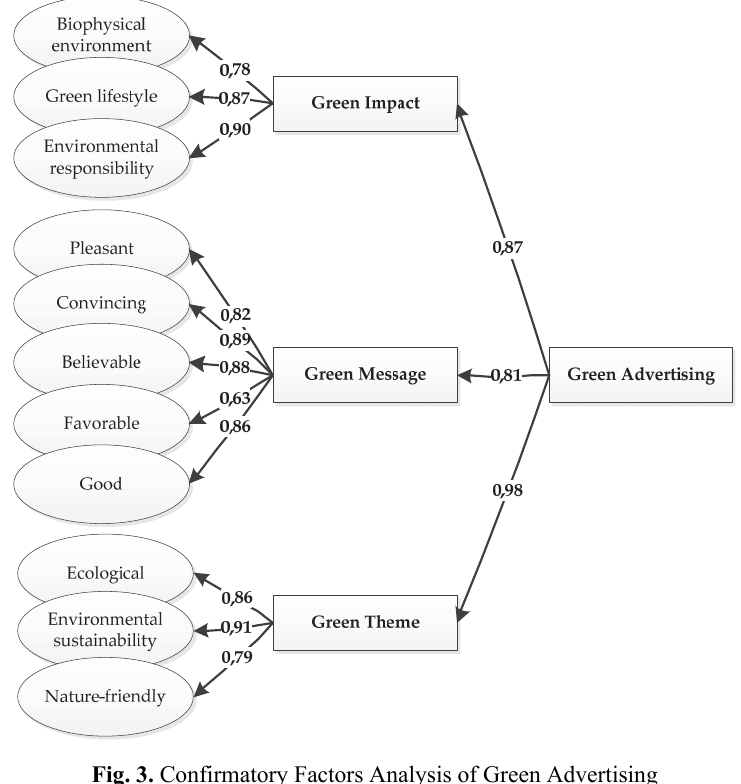
Fig. 3. Confirmatory Factors Analysis of Green Advertising